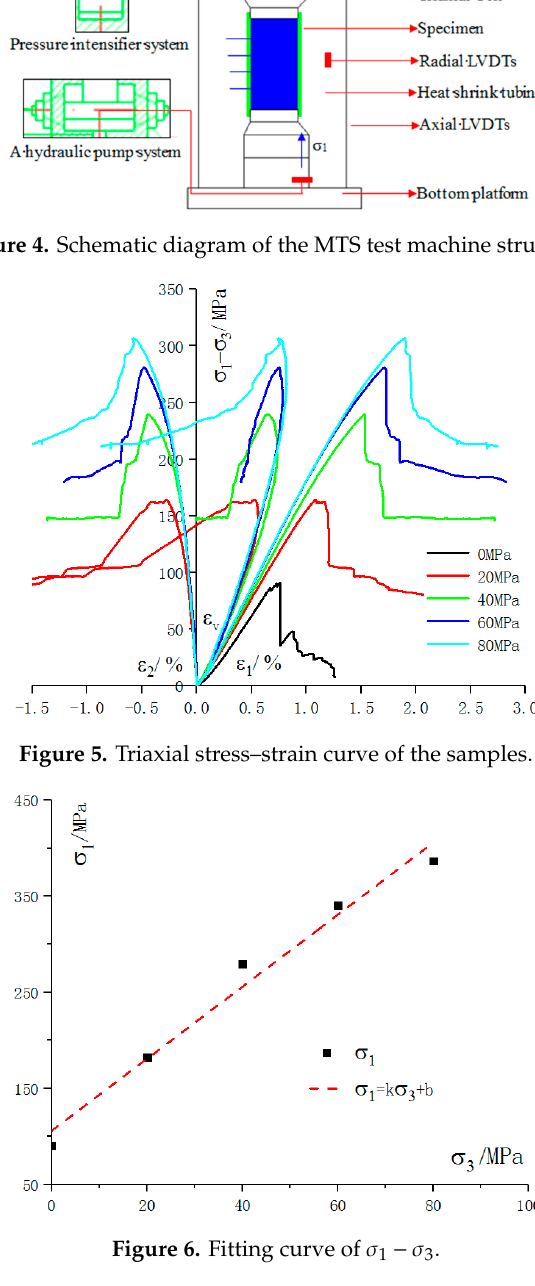
Figure 5. Triaxial stress–strain curve of the samples. Figure 6. Fitting curve of Figure 6. Fitting curve of